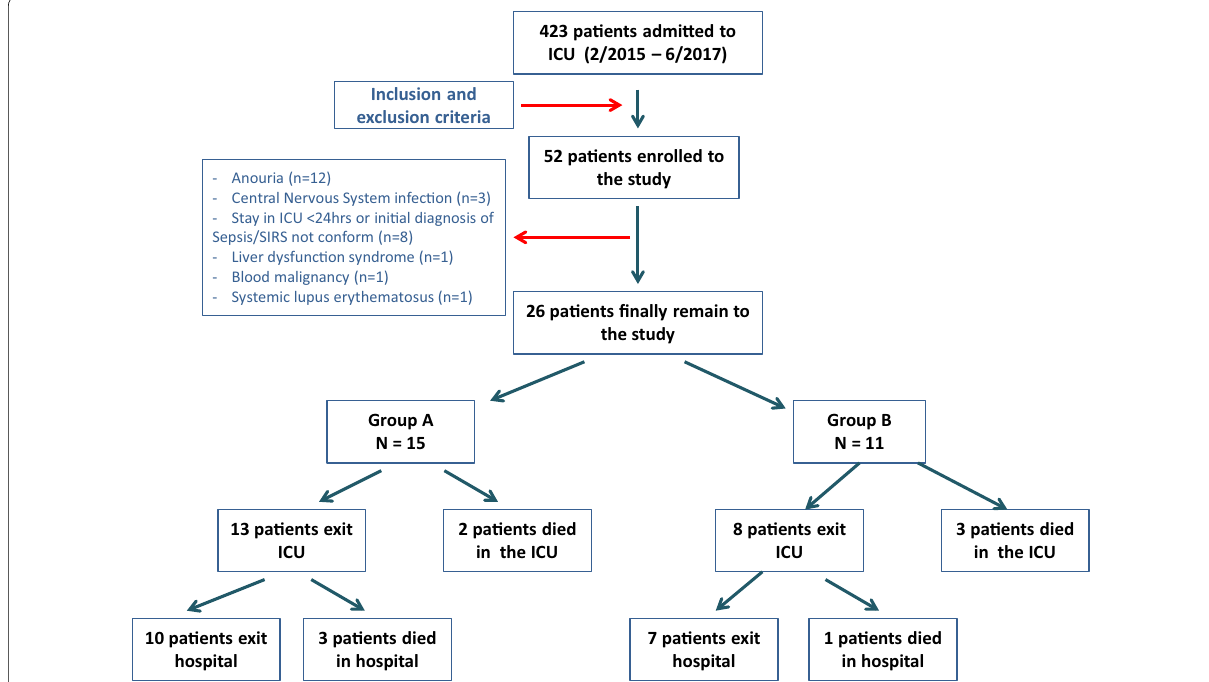
Fig. 1 Flowchart. Flowchart of study design and patients’ characteristics who were enrolled in the study